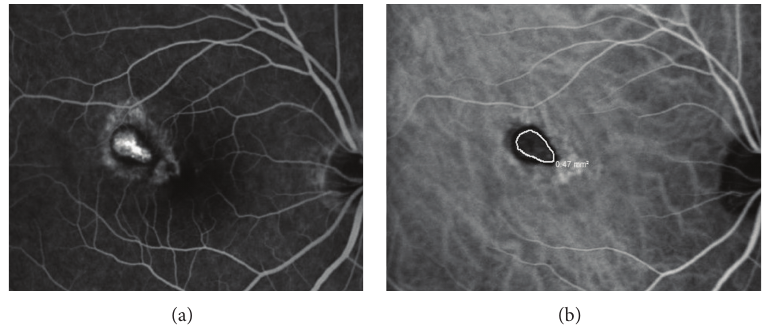
Figure 3: The fluorescein angiography (a) and indocyanine green angiography (b) images of the same subject presented in Figures 1 and 2 two months after two consecutive monthly bevacizumab injections were given. The choroidal neovascularization has decreased 45.3% ((0.86 − 0.47)/0.86) from its baseline value on indocyanine green angiography. The Snellen visual acuity improved to 20/30.